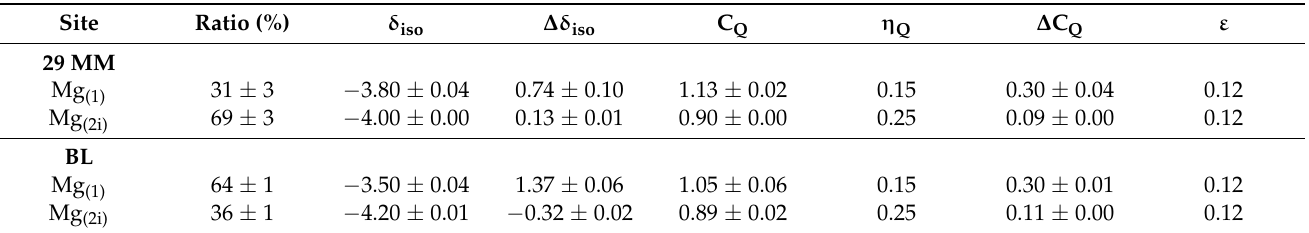
Figure 5. 25 Mg NMR spectra of dolomitic marbles (blue) and their best fit using the parameters displayed in Table 2. STB7: Lez-Saint-B é at quarry, THV7: Thasos Cap-Vathy Quarry, CN1, Coin Quarry, 29 MM, male figure from the Museum of Malaga, BL, moulding from the Roman Theatre of Zaragoza. Table 2. Physico-chemical entities extracted from 25 Mg NMR spectra fit. Ratio expresses the pro- portion of the two sites defined to fit the NMR spectrum (in %); isotropic chemical shift δ iso (ppm), distribution of isotropic chemical shift ∆ δ iso (ppm), average quadrupolar coupling constant C Q (MHz), average asymmetry parameter η Q, distribution of quadrupolar coupling constant ∆ C Q (MHz), and “disorder weight” ε